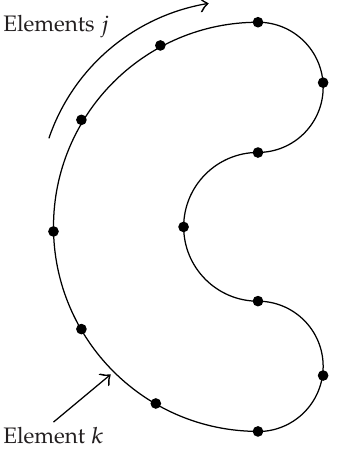
Figure 2.1. Boundary of the